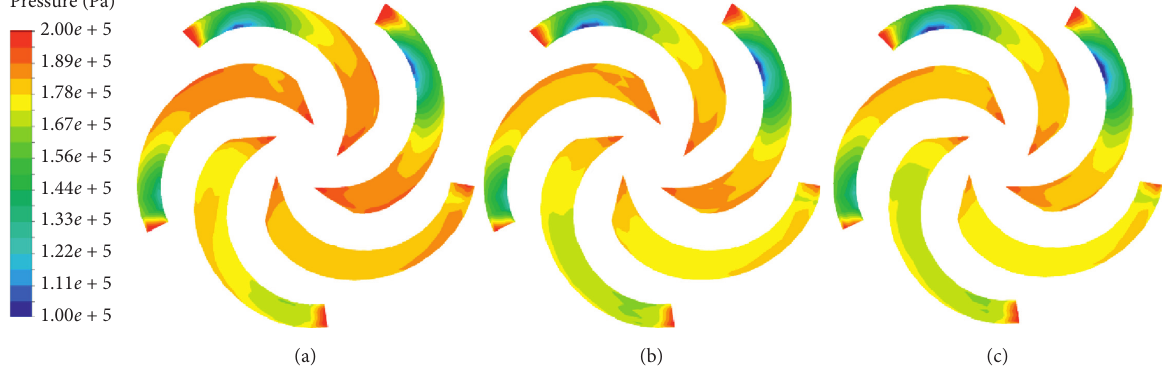
Figure 14: Pressure distribution on the suction surface of the guide vane: (a) 5mm, (b) 10mm, and (c)